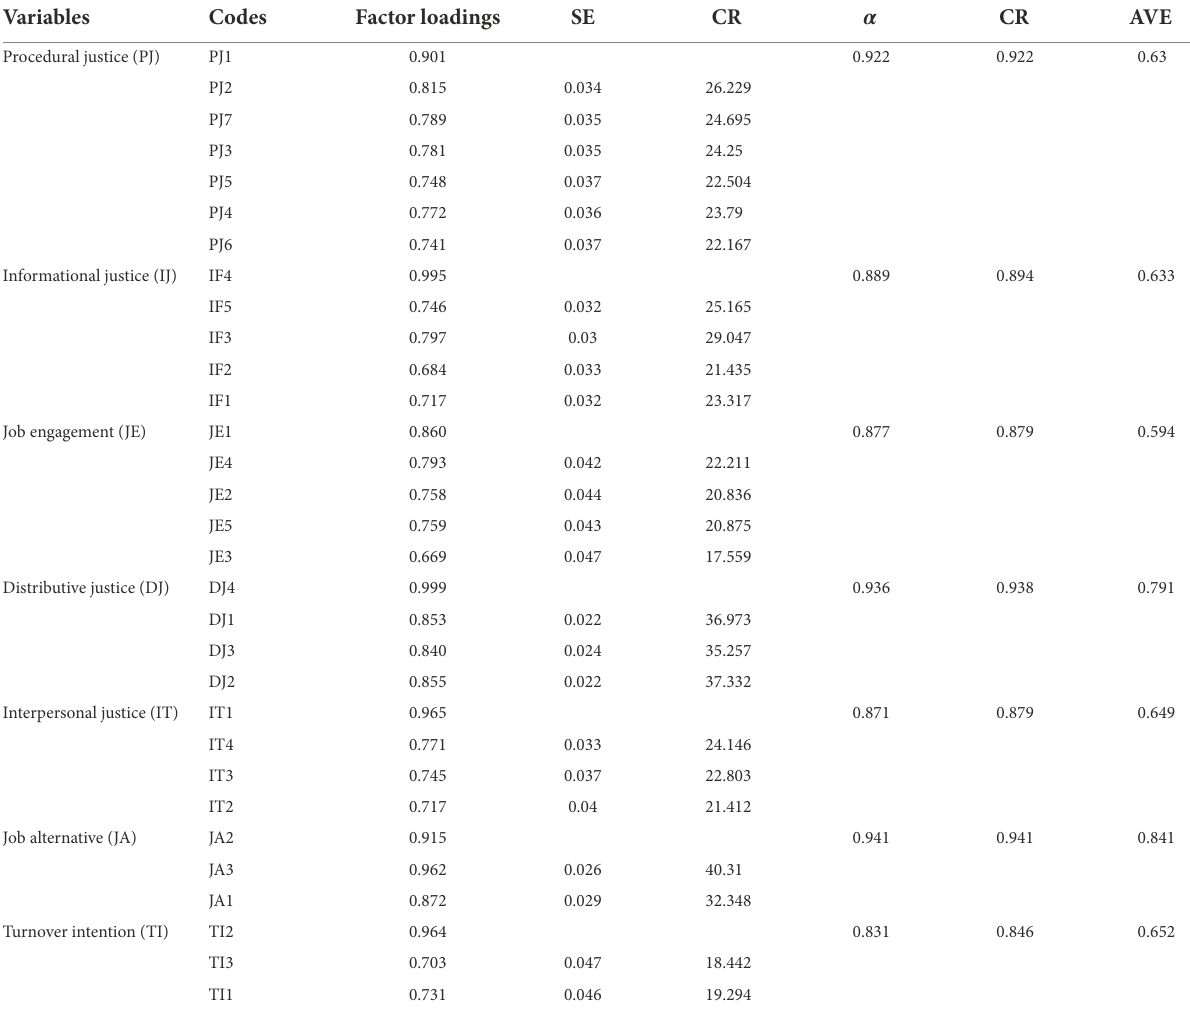
TABLE 1 CFA factor loadings, reliability, and validity